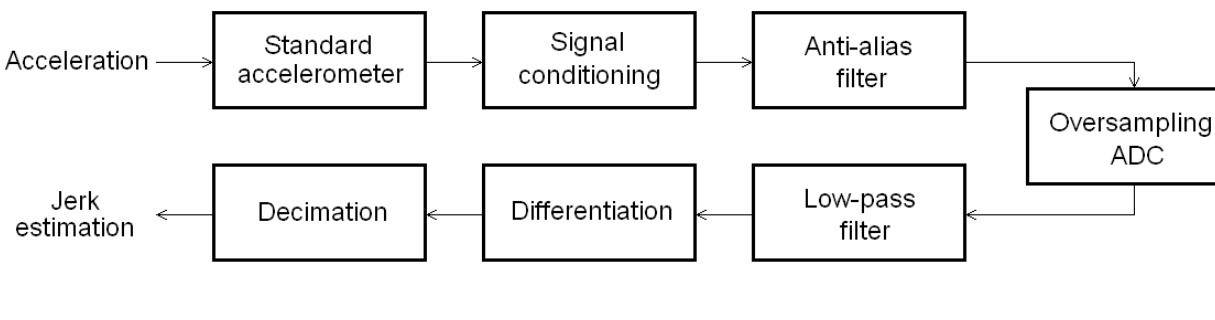
Figure 1. Block diagram of the smart sensor for jerk